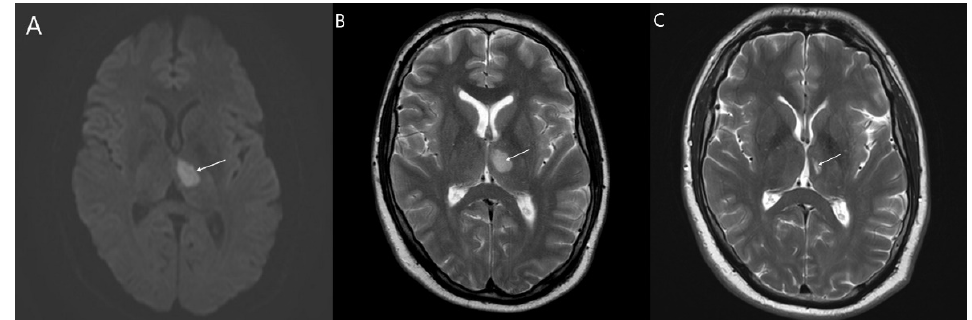
Figure 1. Axial MRI scans illustrate an infarct in the left medial thalamus (white arrows) of the patient 1.0 on day 3 post-stroke ( A , B ) and at 3 months post-stroke ( C ). ( A ) Diffusion-weighted imaging shows large lesion with restricted diffusion in the thalamus. ( B ) T2-weighted imaging shows hypersignal lesion; ( C ) After 3 months there is smaller hypersignal lesion as residual lesion.